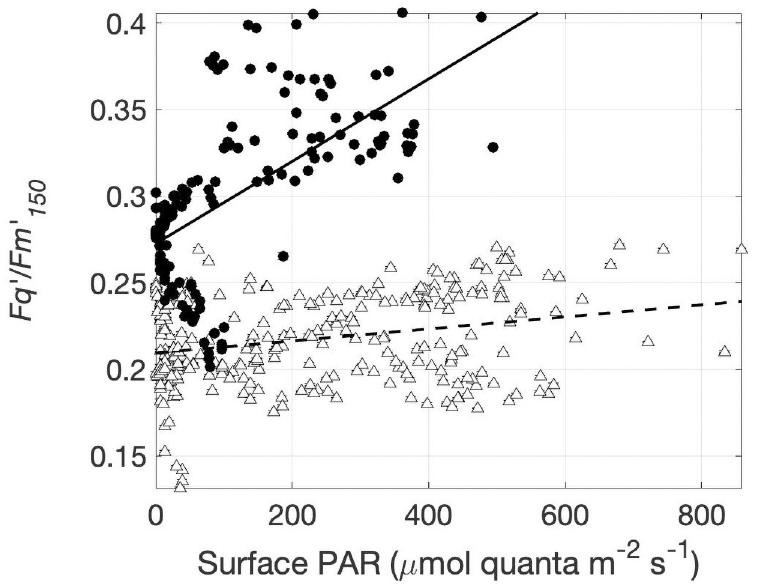
Fig 5. Recent light history effects on photophysiology measured under low light. The PSII photochemical efficiency measured under 150 μ mol quanta m -2 s -1 in relation to natural surface irradiance at the time of sample acquisition. Lines of best fit are shown for Barrow Strait (solid line) and Lancaster Sound (dashed line). Full regression analyses results are reported in S2 Table. Error bars show standard error, but are often concealed by size of data